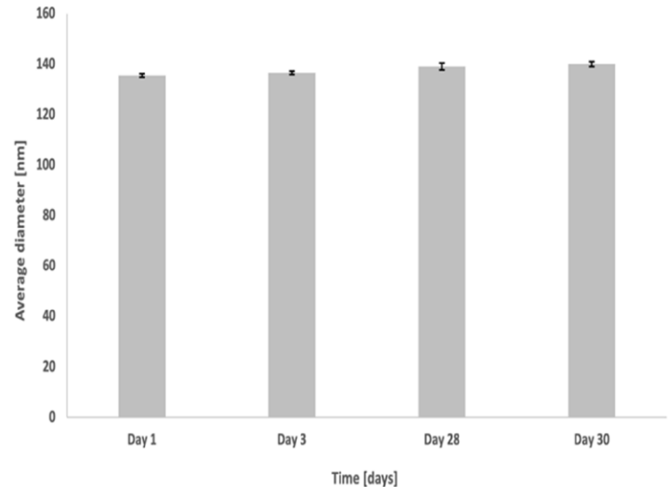
Figure 1. Stability of nanoemulsion droplets size over time.